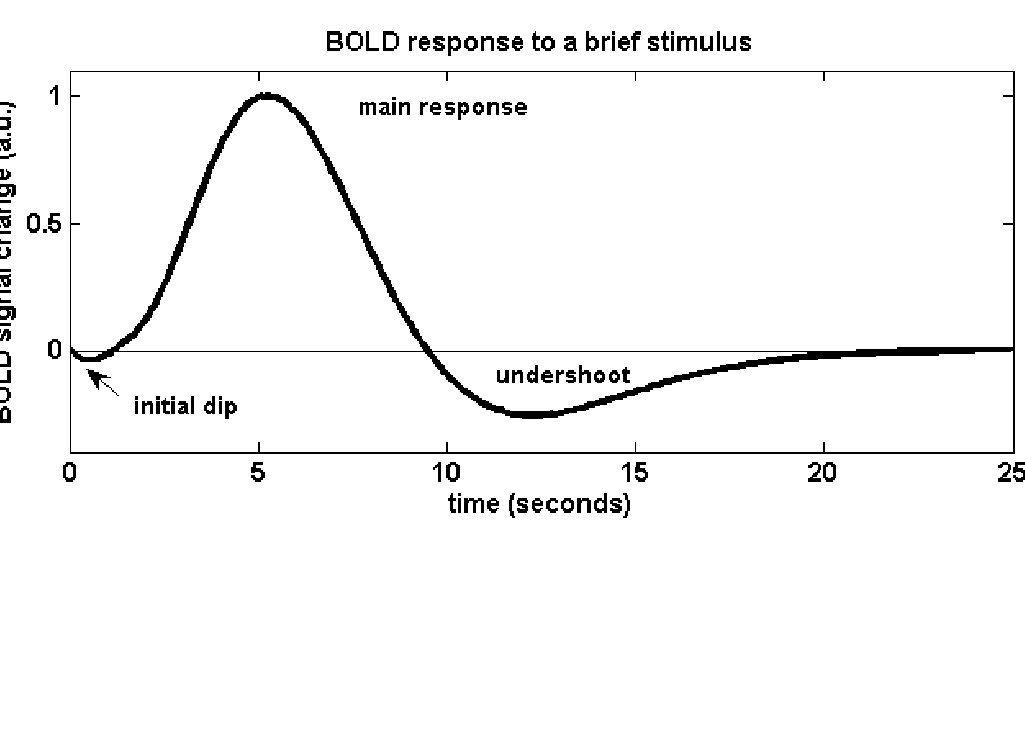
Figure 1. Schematic of the BOLD hemodynamic response to a brief stimulus at time